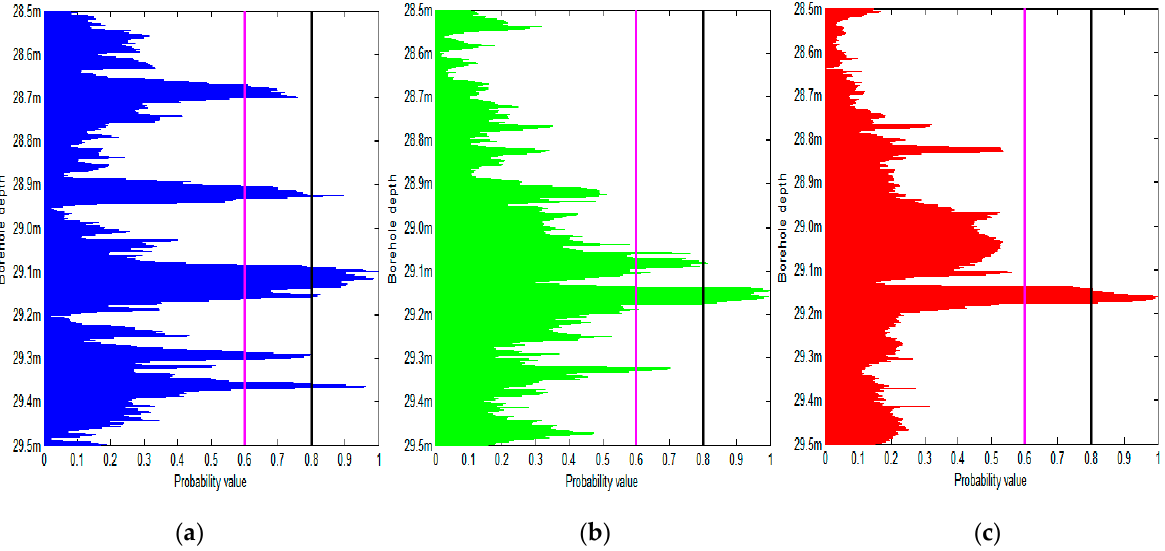
Figure 19. Probability value distribution of the identified results by the different methods. ( a ) Image recognition method, ( b ) this article’s recognition method, ( c ) sound speed recognition method.